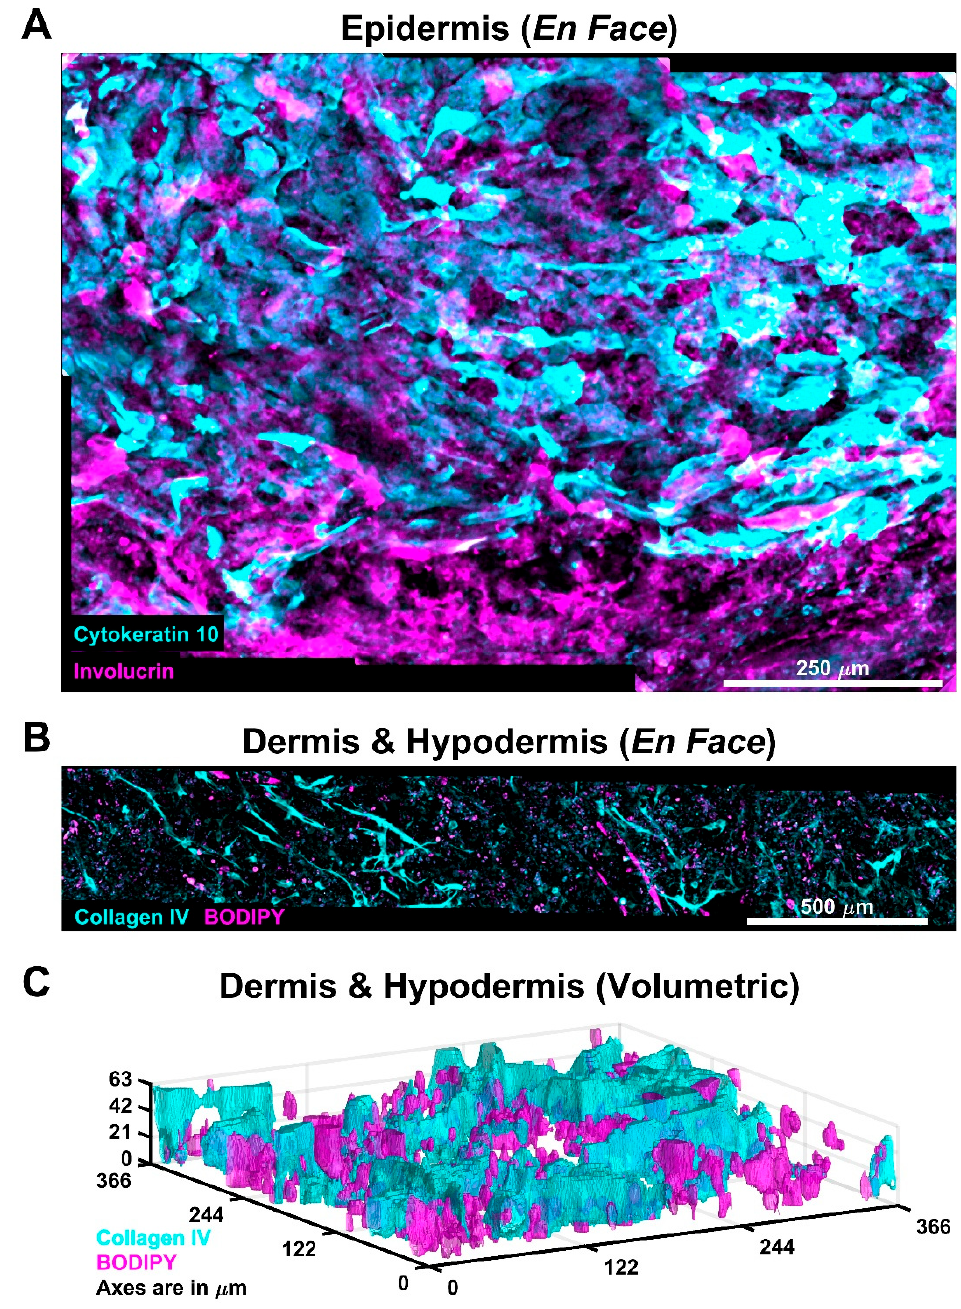
Figure 2. AVHSE allow for large-scale assessment of cultures. ( A ) Demonstration of scale of epidermal analysis. Cytokeratin 10 (cyan) is a suprabasal epidermal marker and Involucrin (magenta) is a stratum corneal marker. Image is an en face max projection of ~0.7 × 1 × 0.2 mm volume. ( B ) Adipose and vasculature morphology can be assessed at scales that span 3.6 mm (approximately half of this representative AVHSE), presented as an en face max projection. Collagen IV (cyan) marks the vasculature and BODIPY (magenta) marks lipid droplets secreted from mature fat cells (magenta). ( C ) Volumetric rendering of segmented Collagen IV (cyan) and BODIPY (magenta), demonstrating vascular infiltration into the hypodermis. Images were acquired pre-clearing and are median filtered for clarity.